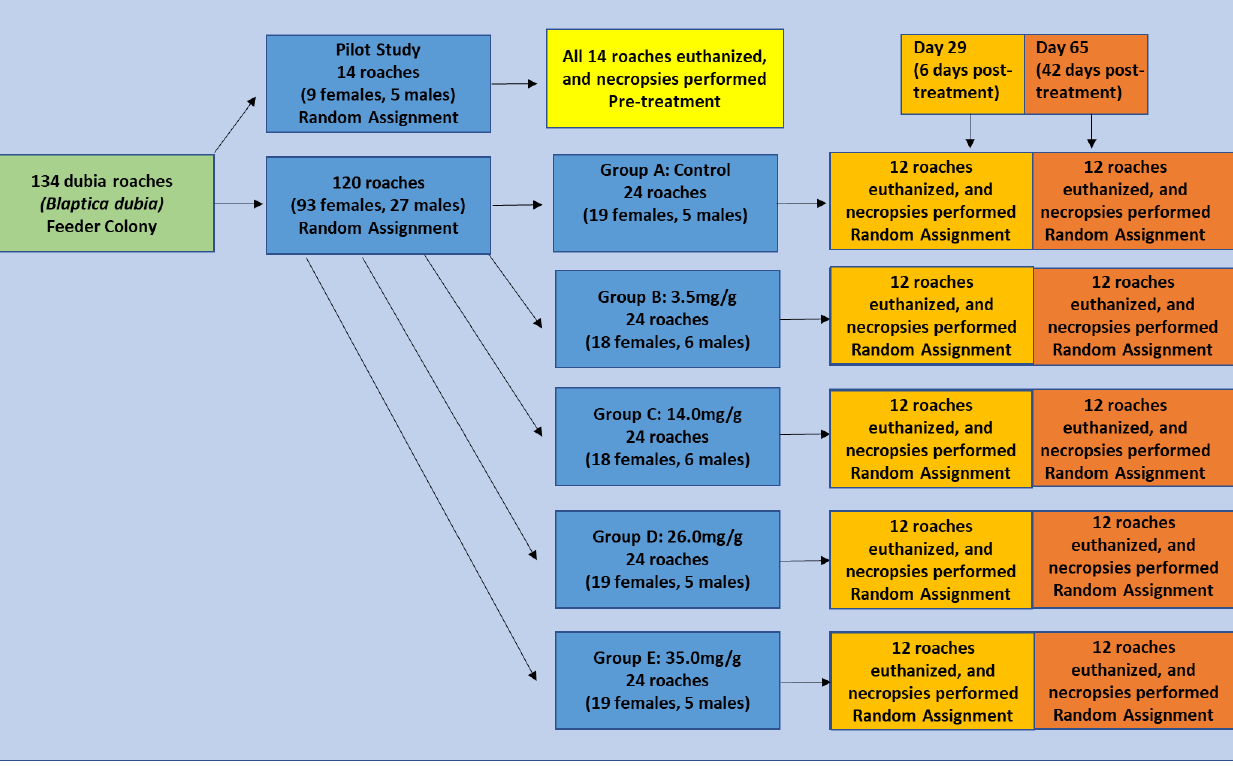
Figure 3. Dubia roach ( Blaptica dubia ) assignment into both the pilot study and the main study research groups (control, A – E).